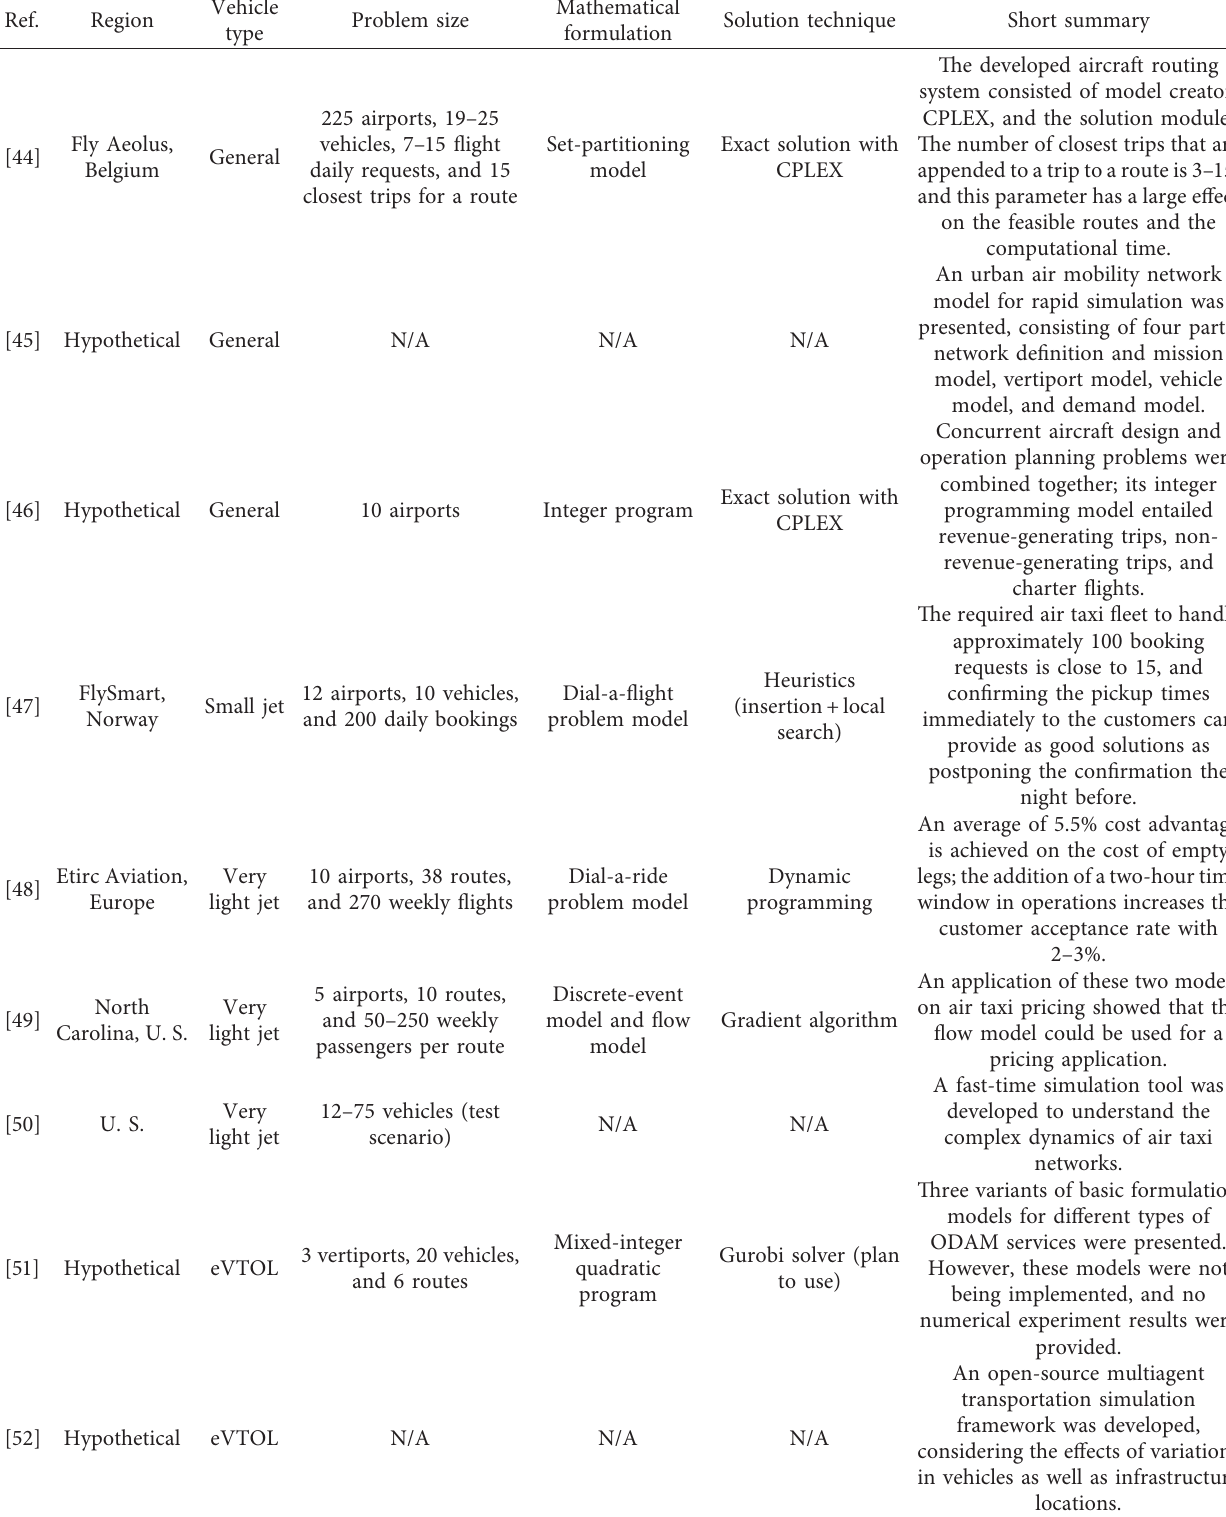
Table 3: An overview of the ODAM operational planning